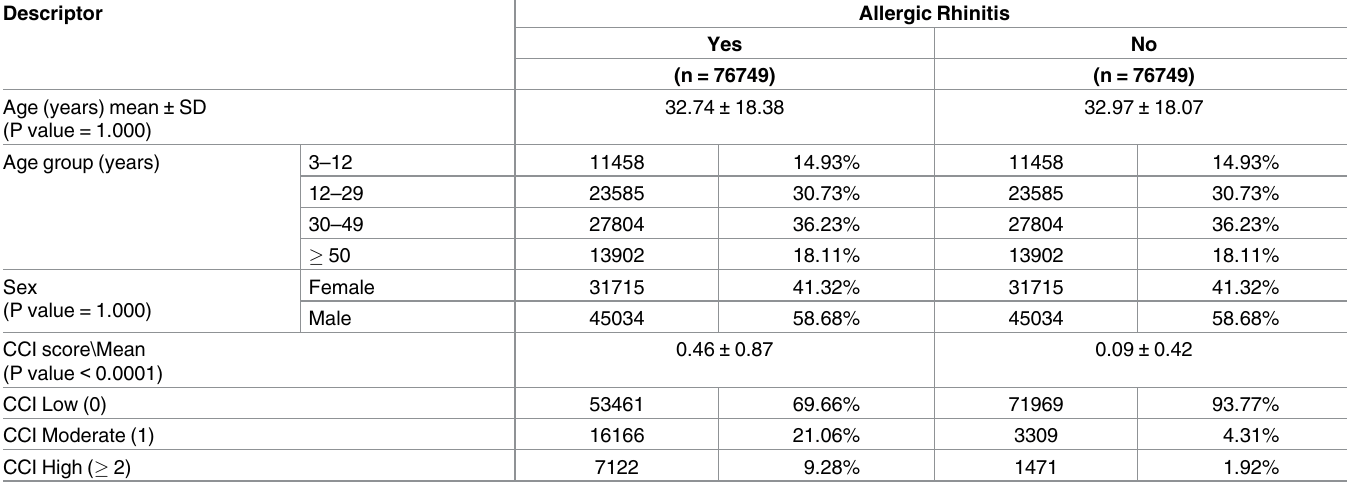
Table 1. Demographic characteristics of patients with allergic rhinitis and those without non-allergic rhinitis.